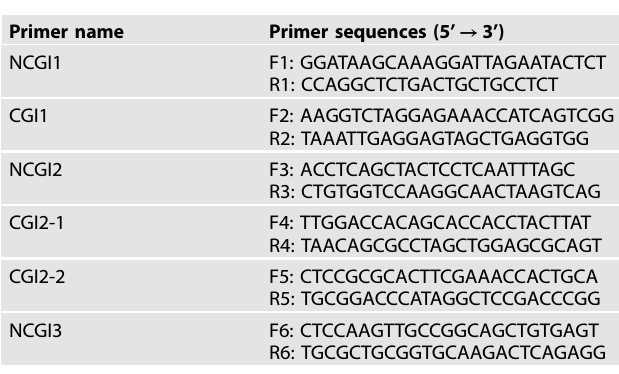
Table 4. Primers used for BSP.